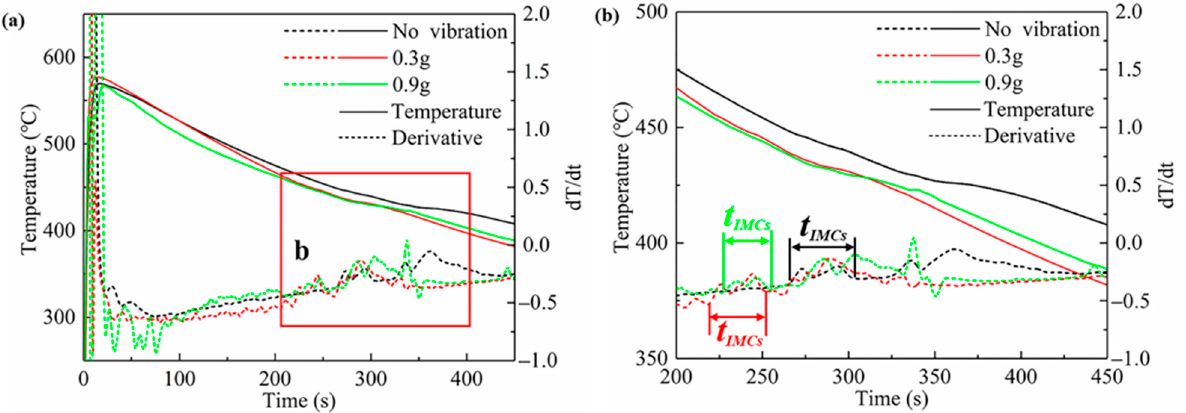
Figure 12. ( a ) Results of thermocouple measurement; ( b ) Temperature curve zoom in area b in ( a ).